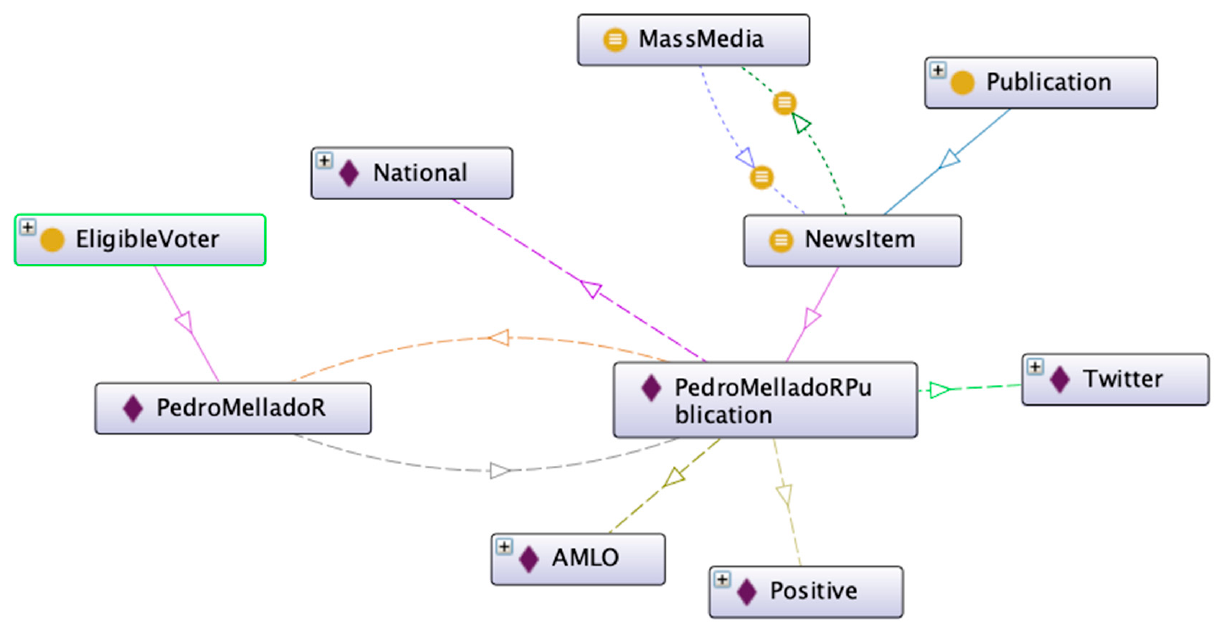
Figure 7. New instance displayed in OntoGraf.